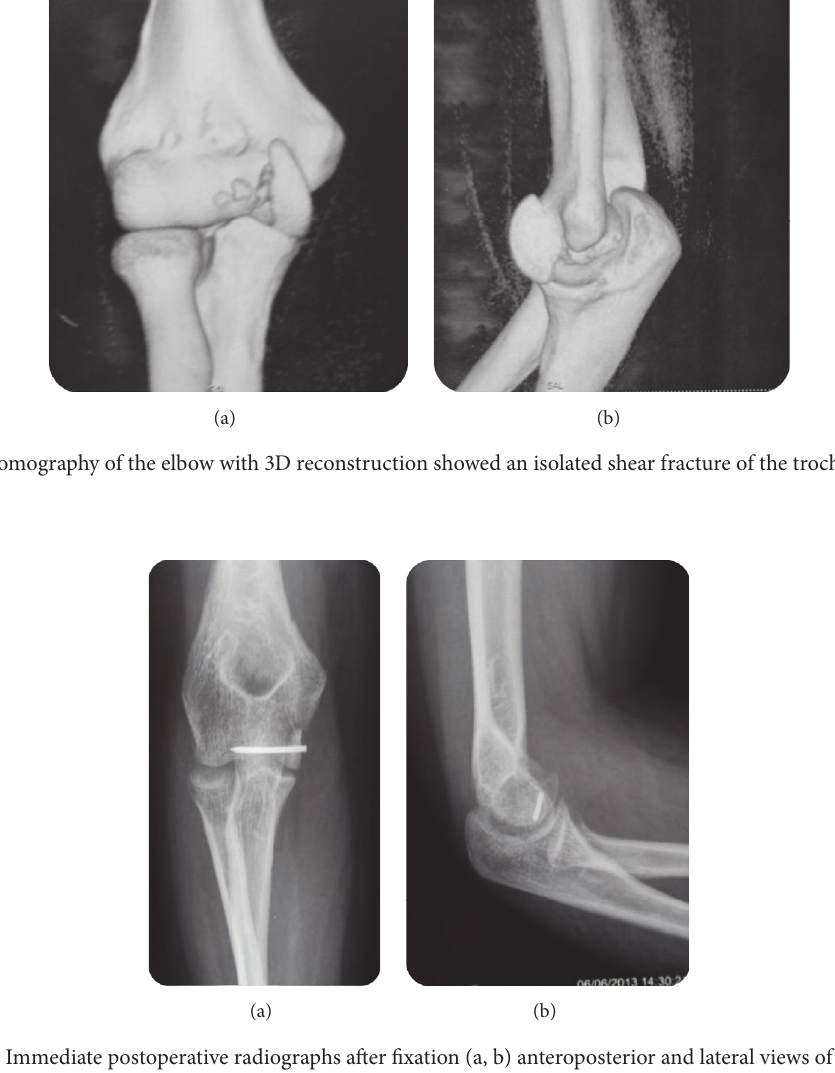
Figure 4: Immediate postoperative radiographs after fixation (a, b) anteroposterior and lateral views of the elbow.